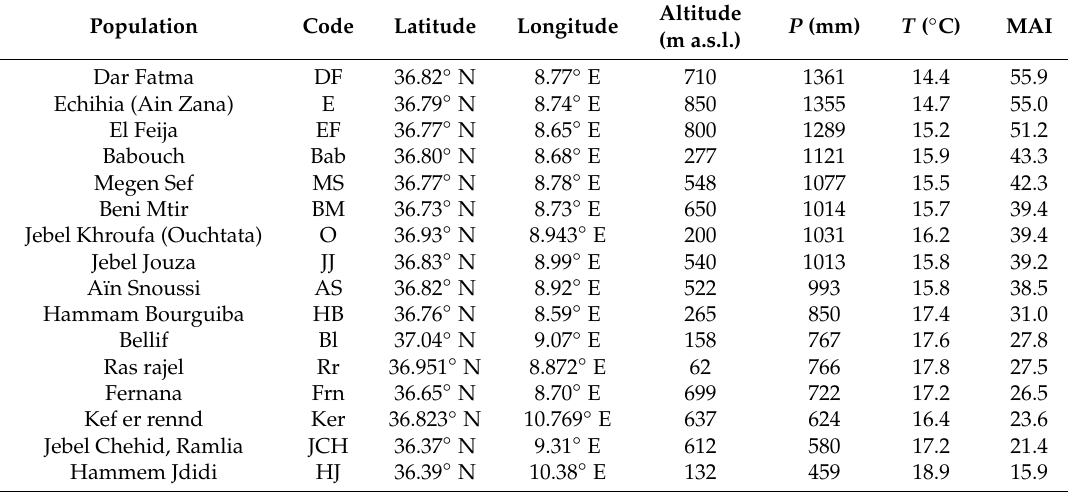
Table 1. Geographical and climatic characteristics of each Quercus suber population. P , annual precipitation; T , annual mean temperature; MAI, De Martonne aridity